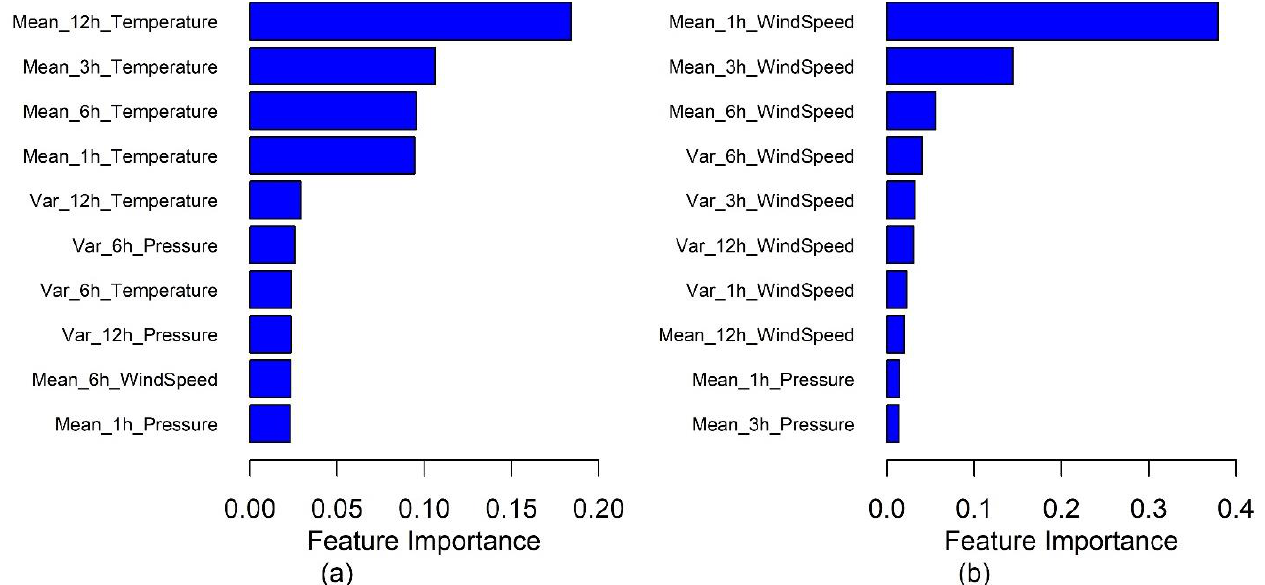
Figure 8. Feature importance of ( a ) heatwave and ( b ) strong wind RF models.